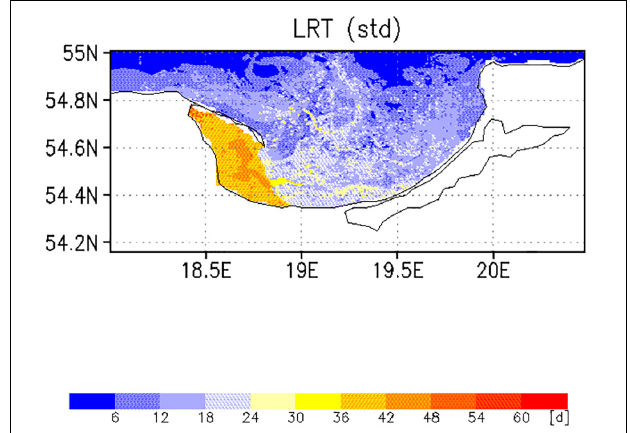
FIGURE 10 | Standard deviation of the LRT (in days) for the Bay of Gda´nsk in 2009.